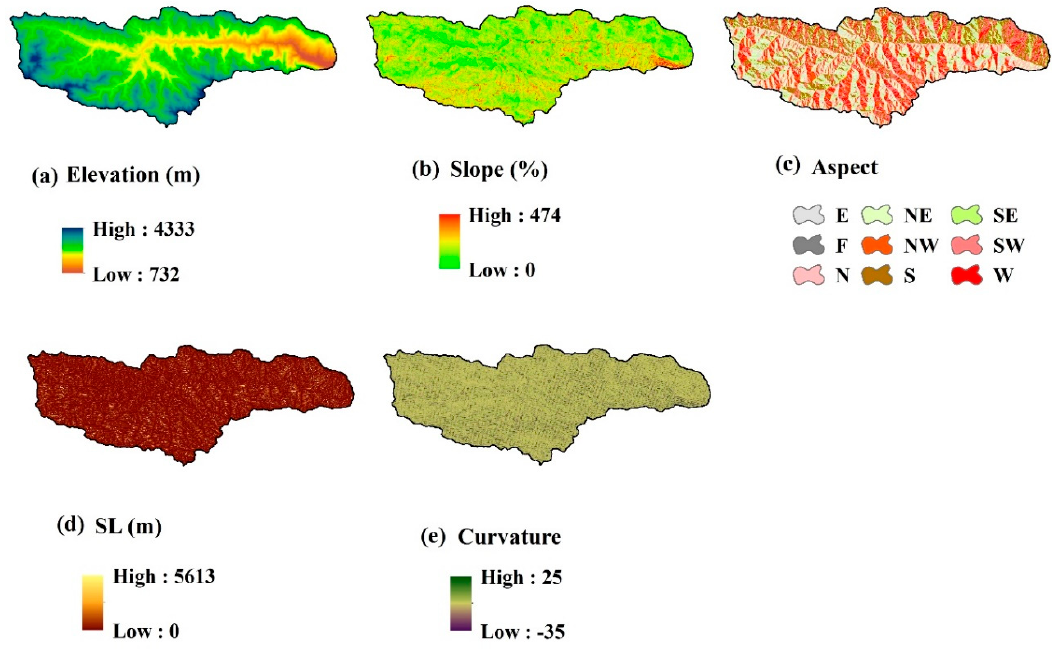
Figure 3. Topographic factors: ( a ) elevation, ( b ) slope, ( c ) aspect, ( d ) slope length (SL), and ( e ) curvature.